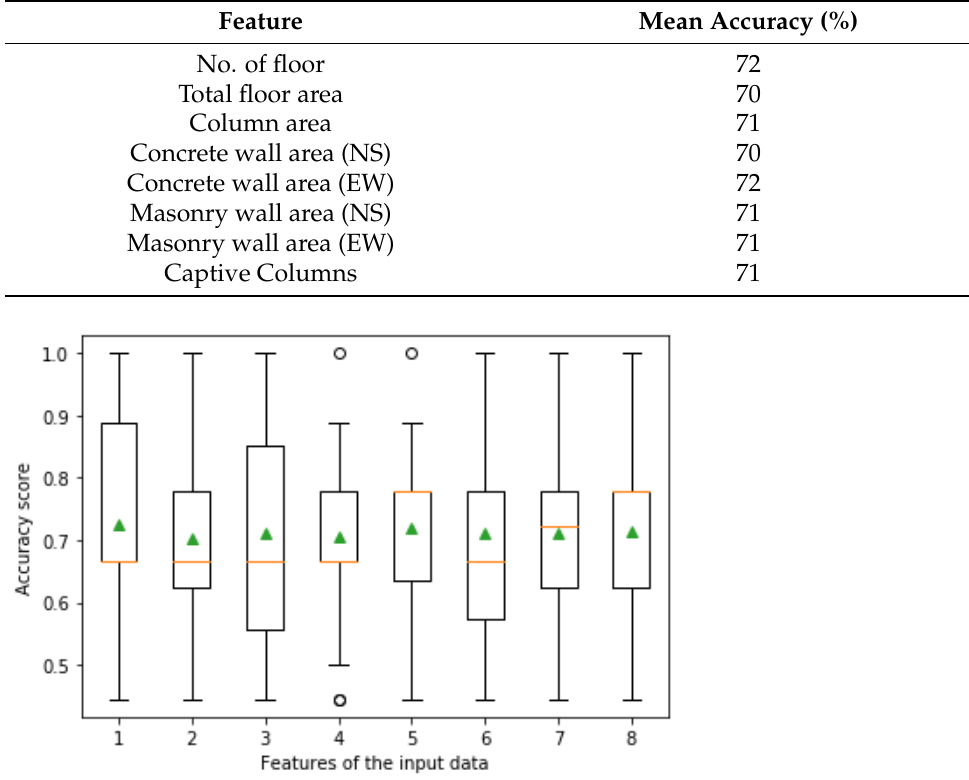
Table 13. Pohang: Predictive accuracy score against each input feature.